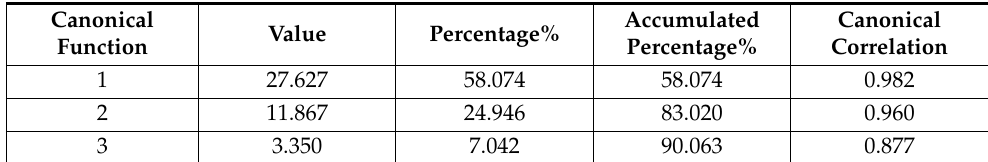
Table 2. Summary of the canonical discriminant analysis of 11 quantitative anatomical characters of the evaluated